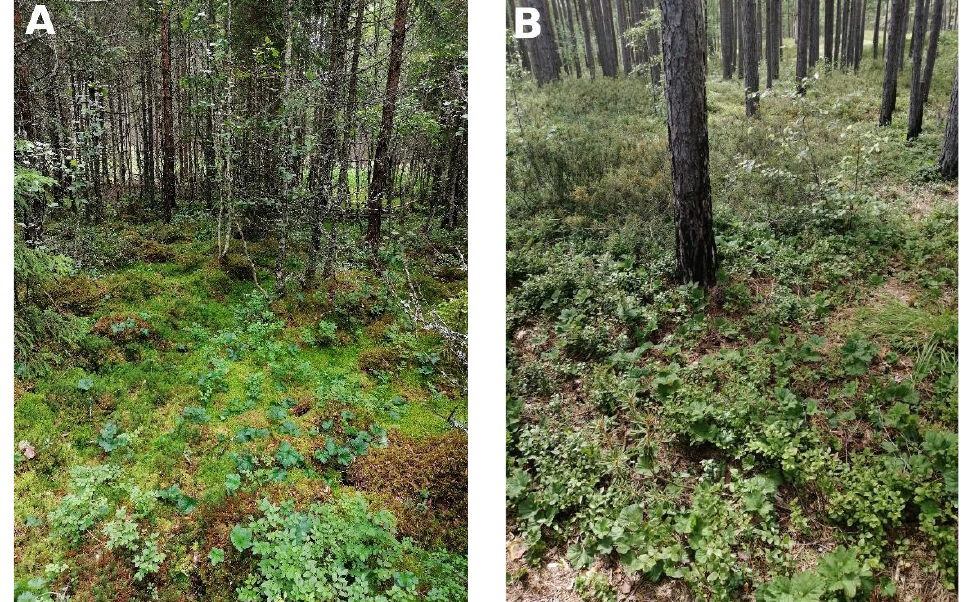
Figure 1. Habitats of wild cloudberry representing two plant community classes, ( A ) Cl . Oxycocco- Sphagnetea and ( B ) Cl . Vaccinio-Piceetea (photos by L. Āboliņa).